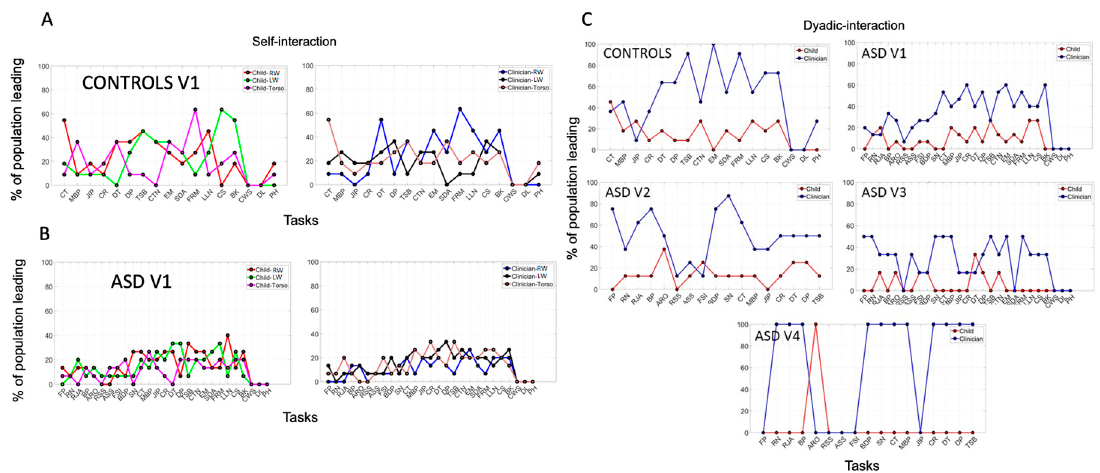
Figure 4. Mirroring Bias Effects. ( A , B ) Biased rating in the ADOS test quantified through mirroring metric of lead-lag social patterns of self-interactions (individual kinematic synergies) as percentage in leading patterns across the cohort. Neurotypical Controls and Clinician show broader range of values than Autistics the visit one, under the most appropriate module and same rater. ( C ) Mirroring effect and raters’ leading bias persist in the shared dyadic cohesiveness as the module and rater change. Visit one and three (appropriate module) under two different raters show a reduction in parameter range for autistics relative to controls. Visit two and four (less appropriate module and by then familiar rater) show an increase in parameter range for autistics relative to visits one and three.